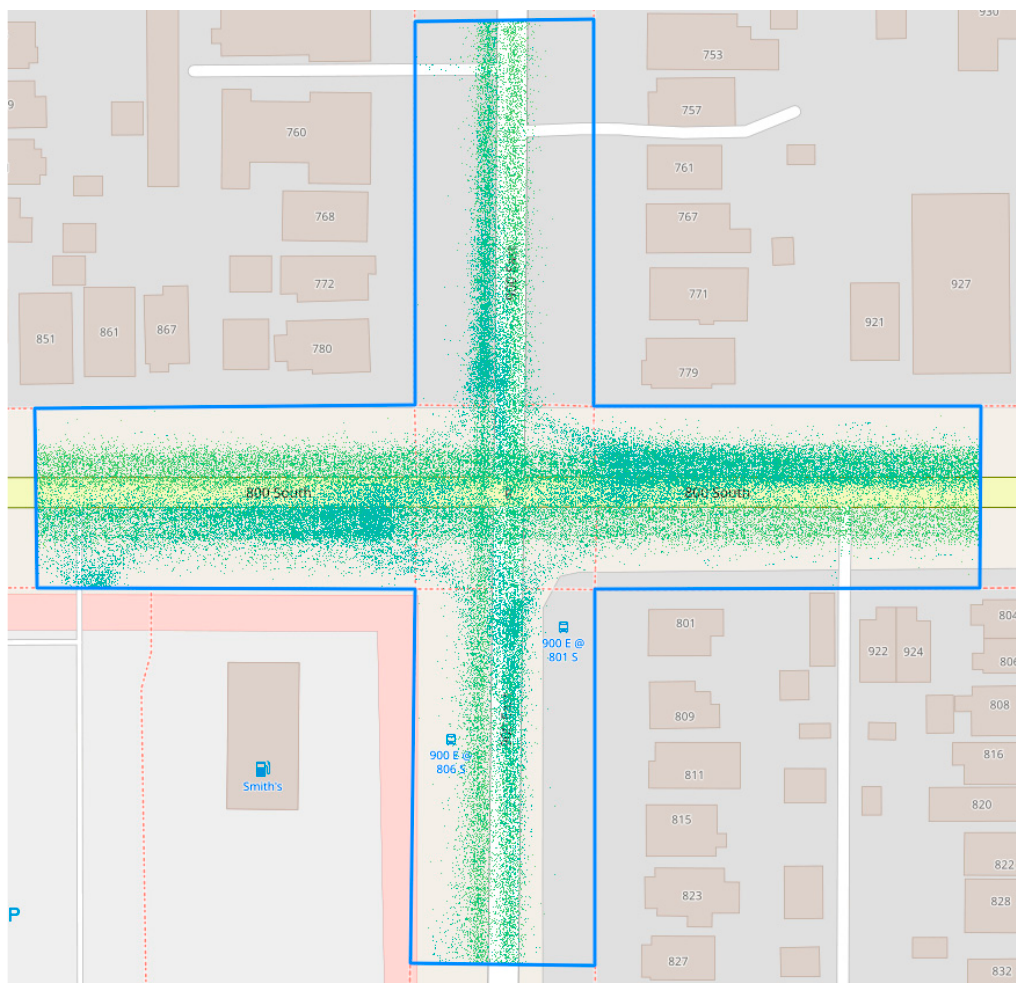
Figure 1. Intersection influence area with waypoints displayed.